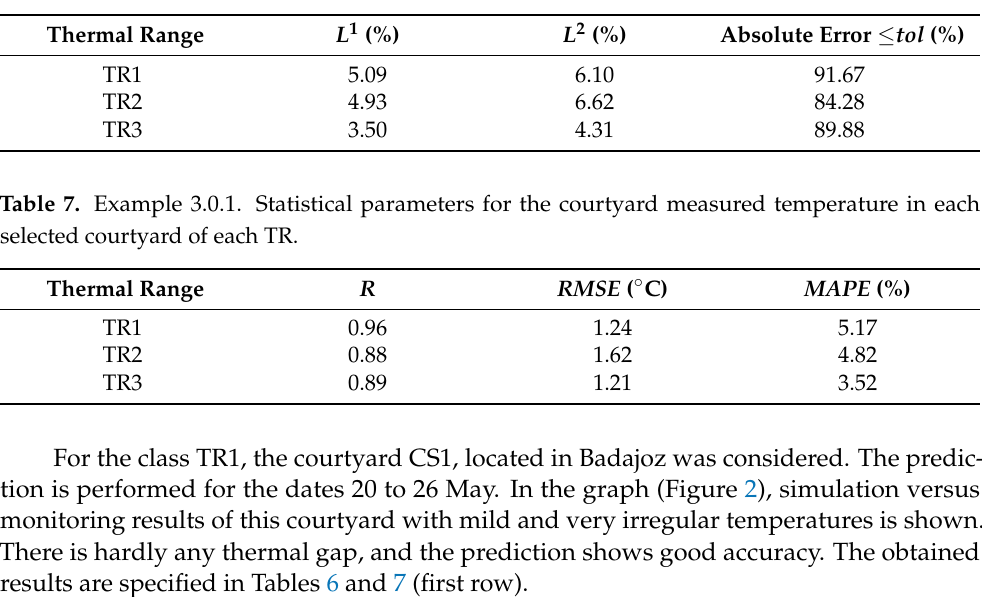
Table 6. Example 3.0.1. Relative and absolute errors for the courtyard measured temperature in each selected courtyard of each TR.